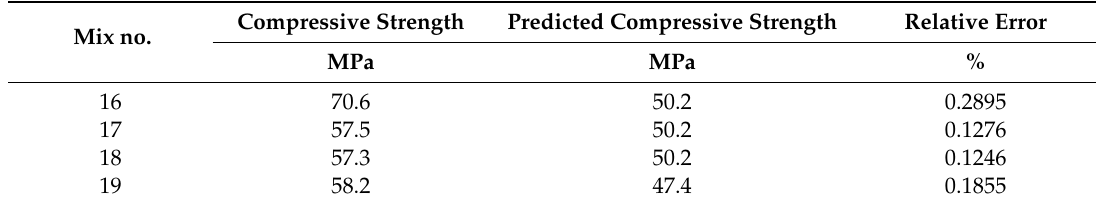
Table 5. Predicted results of the linear regression equation.